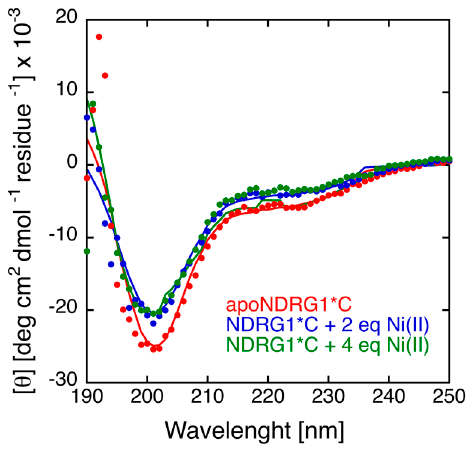
Figure 3. Far-UV CD spectra of h NDRG1*C in the absence and in the presence of increasing concen- trations of Ni(II).